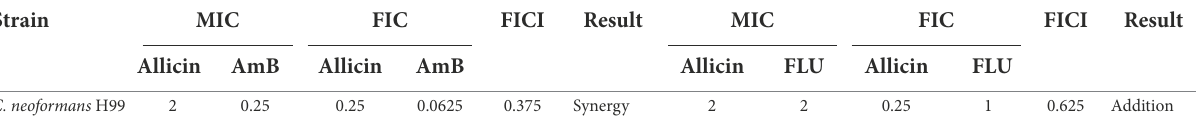
TABLE 2 Combined efficacy of allicin with AmB and